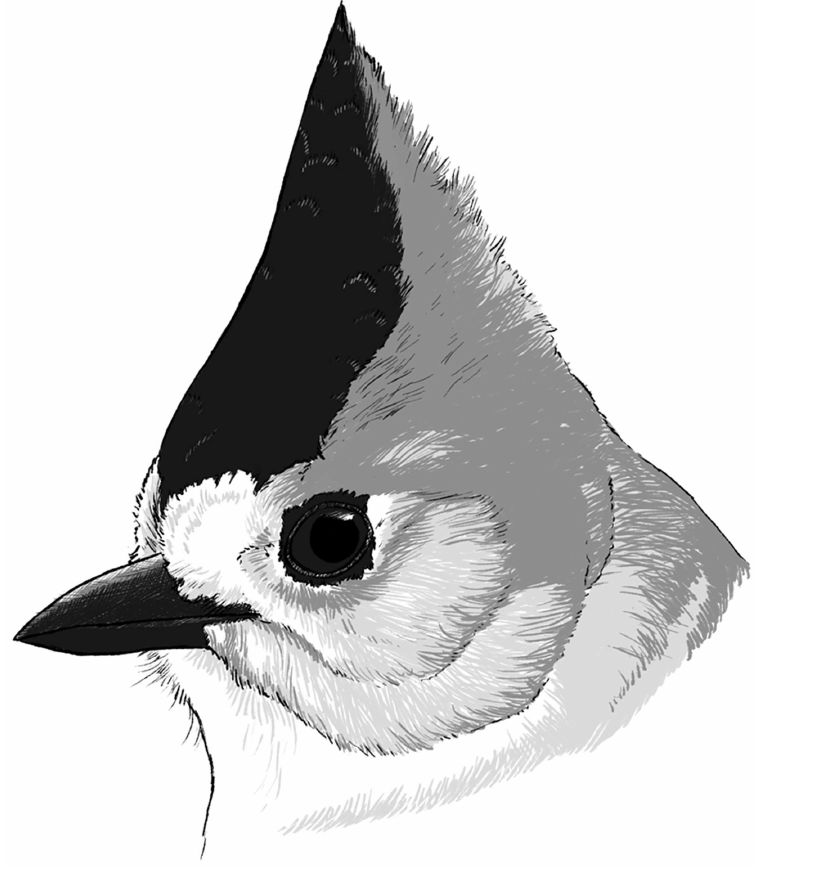
Fig 1. Crest of the black-crested titmouse, Baeolophus atricristatus